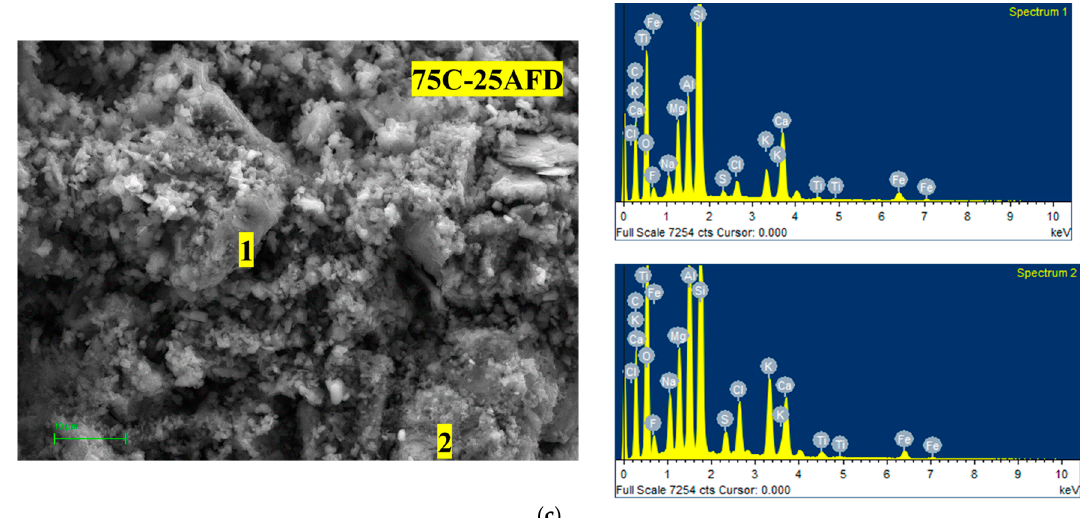
Figure 7. SEM micrograph with EDAX analysis at different points of ( a ) 100C, ( b ) 90C-10AFD, and ( c ) 75C-25AFD bricks.